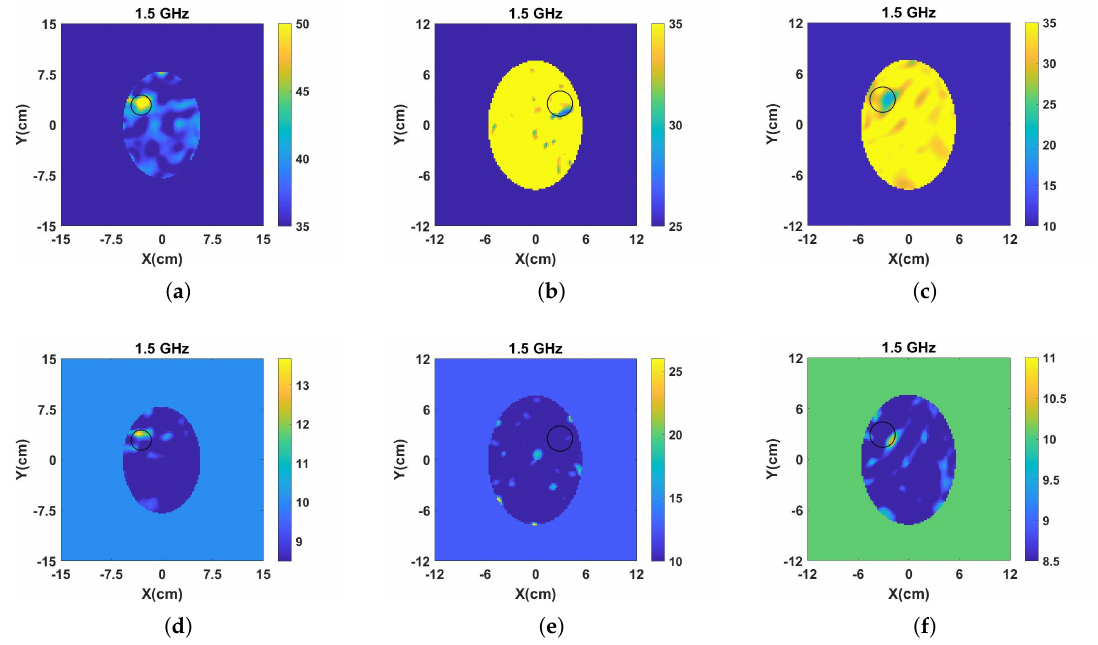
Figure 6. Reconstructed: ( a–c ) real and, ( d–f ) imaginary part of the complex permittivity for h-stroke (left), 25% i-stroke (middle) and 50% i-stroke (right). The complex permittivity was calculated at 1.5 GHz using the frequency hopping approach in a frequency range of 0.7–1.5